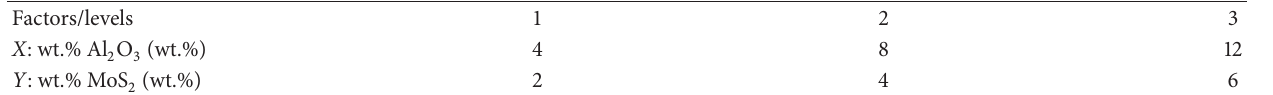
Table 2: Affecting factors and levels selected for tensile strength Al6061/Al 2 O 3 /MoS 2